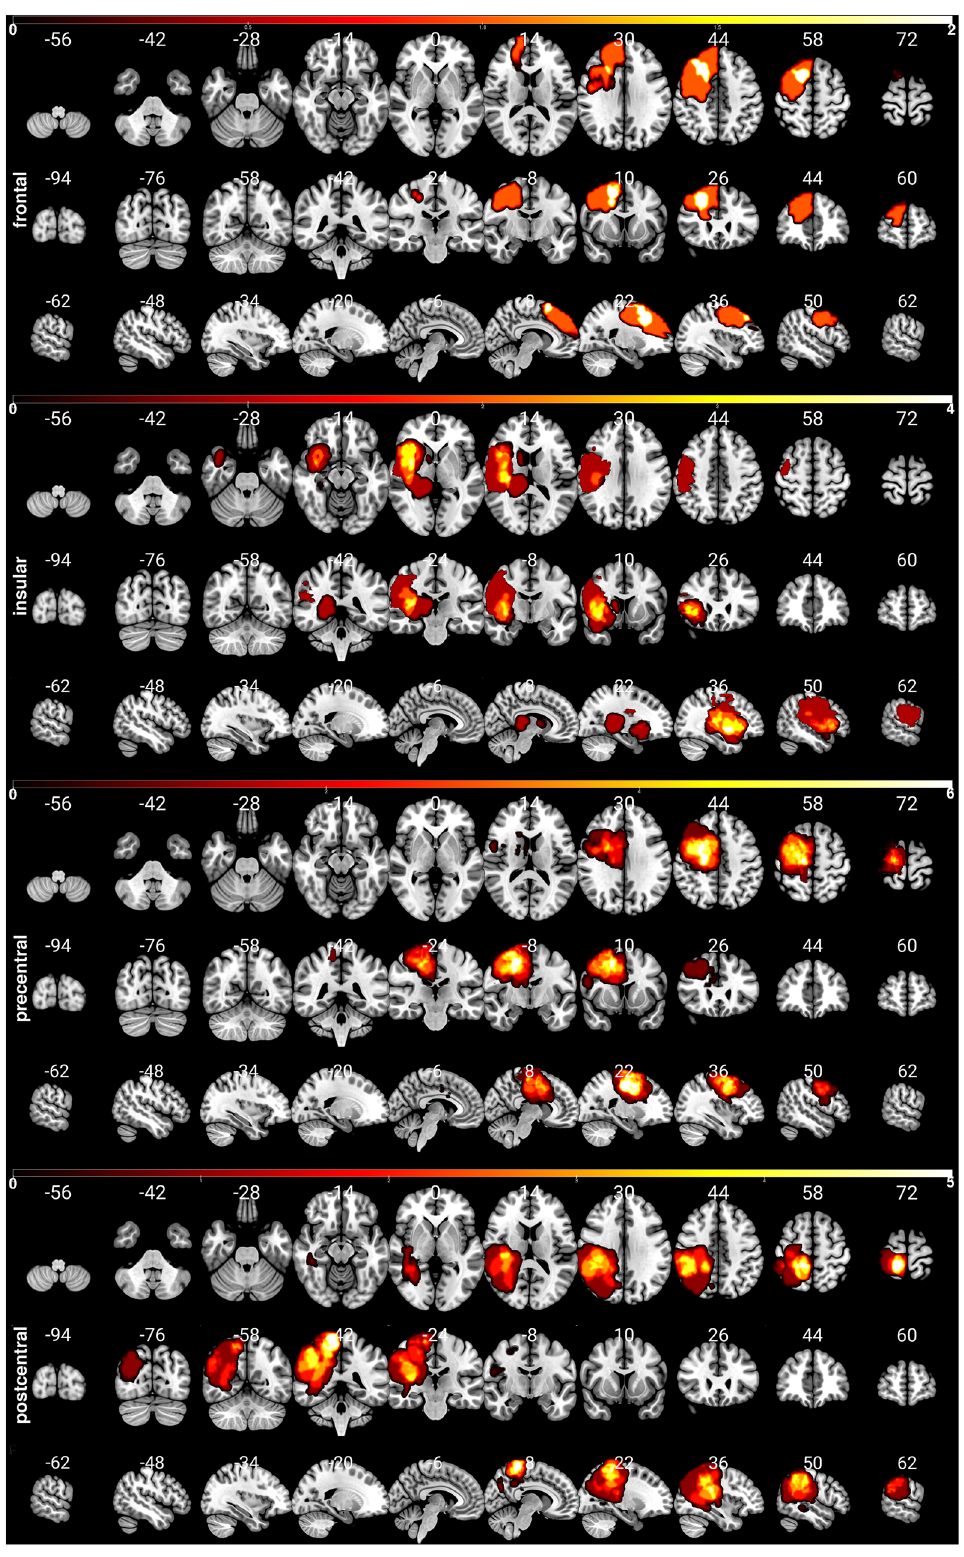
Fig. 1 Distribution of the subgroups ’ patients ’ lesions (frontal, insular, precentral, and postcentral). The color bar indicates the occurrence of lesions per voxel. To enable a clear comparison of lesion location, lesions of the left hemisphere were mapped to the right hemisphere.